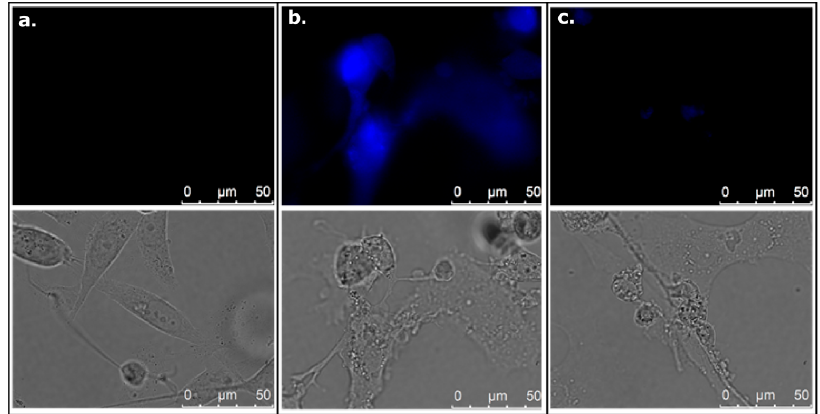
Figure 9. Impact of cellular pH on 6,7-dihydroxycoumarin fluorescence. ( a ) Prostate cancer cells treated with a vehicle (control) and incubated in pH 7.4; ( b ) prostate cancer cells treated with 0.2 mM 6,7-dihydroxycoumarin and incubated in pH 7.4; ( c ) prostate cancer cells treated with 0.2 mM 6,7-dihydroxycoumarin and incubated in pH 6.2 (the use of 5 µM nigericin). Cells were analysed in differential interference contrast (lower panel) and in fluorescence (upper panel).